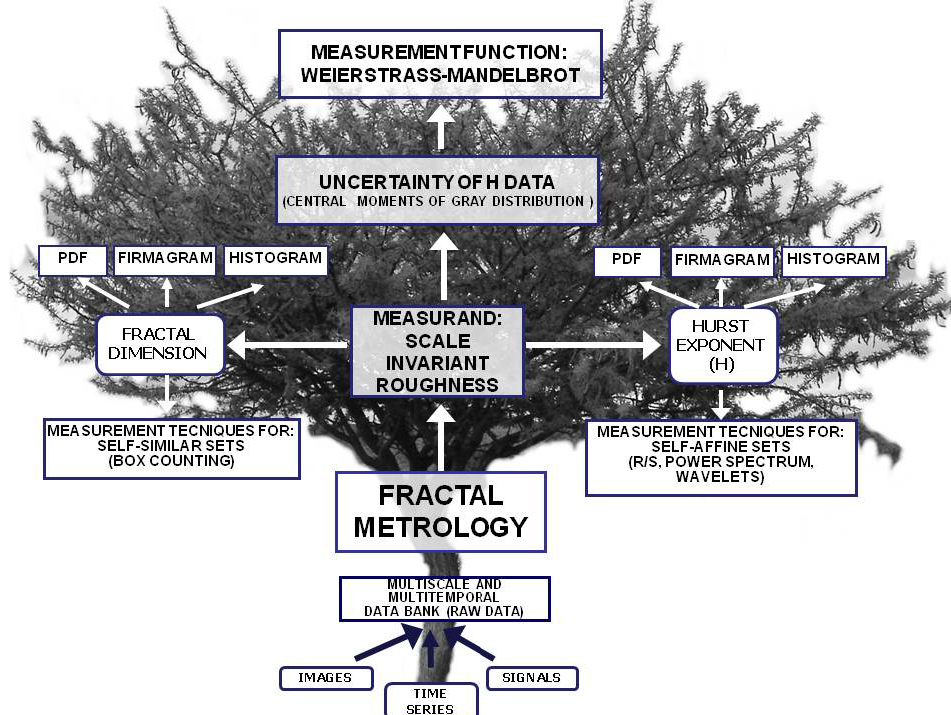
Fig. 2. Hierarchically organized Fractal Metrology